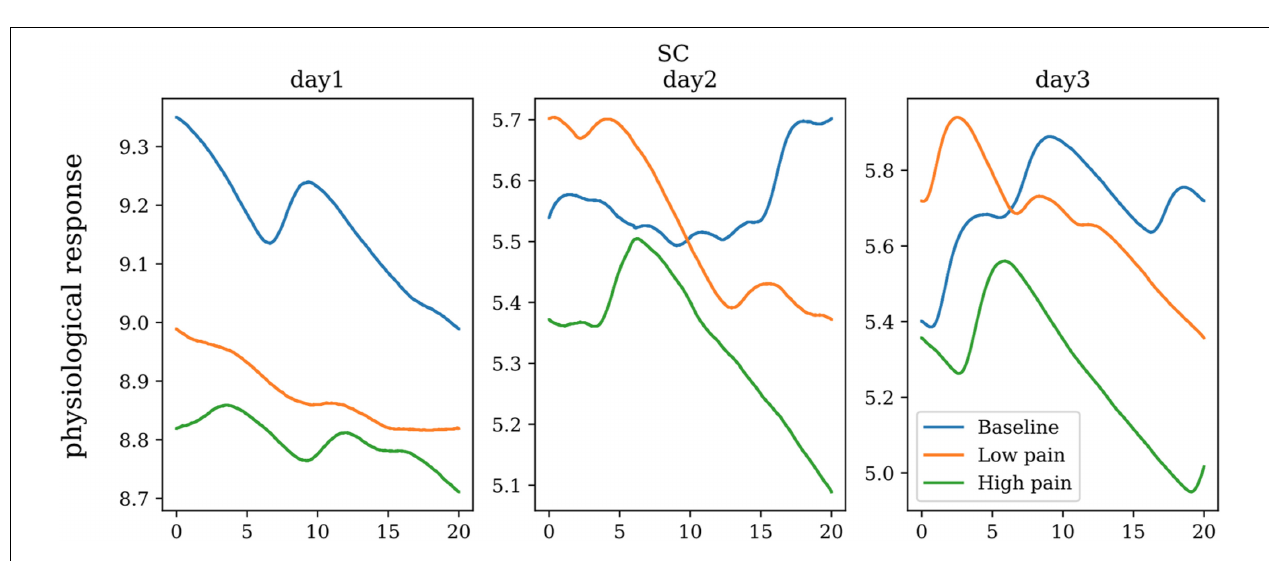
FIGURE 7 | The skin conductance of one subject on three repeated